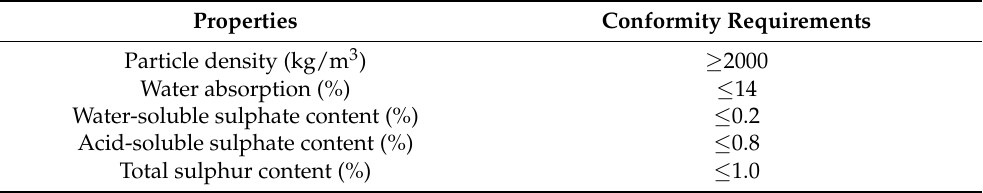
Table 4. Properties and minimum conformity requirements for the use of fine recycled aggregates [1].